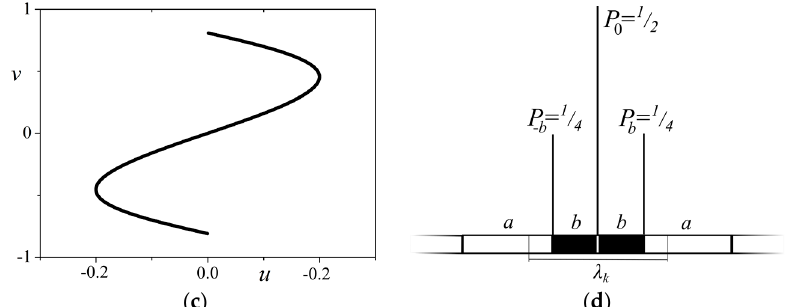
Figure 2. ( a ) Distribution P ( u , v ) , marginal distribution P ( u ) and scaling relation v ( u ) = − τ 2 u for the Fibonacci chain. It is shown that P ( u , v ) is non-zero only along v ( u ) line. ( b ) Distribution P ( u ) and ( c ) scaling v ( u ) for harmonically modulated structure with single modulation term ( A = 0.2, a = 1.0, ξ = τ ). ( d ) AUC for the Thue-Morse sequence with probabilities of two characteristic positions a , b in the chain. Reference lattice parameter λ k = a + b